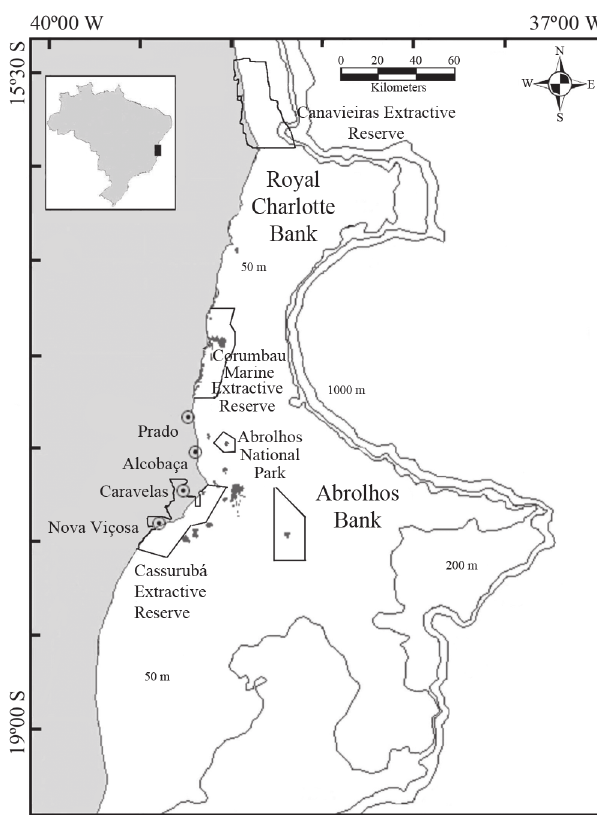
Fig. 1. Map of the study region showing the Abrolhos Bank coral reefs, Eastern Brazil, as well as the marine protected areas and shallow (<50 m) coral reefs.